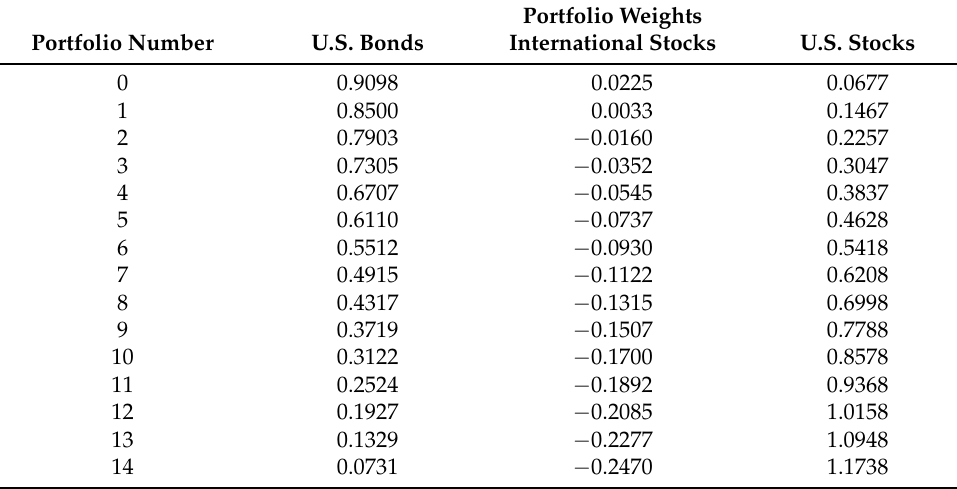
Table 2. The portfolio weights in the three index funds for our 15 portfolios on the efficient frontier, from the most conservative (portfolio 0) to the most aggressive (portfolio 14). Both long-only and long-short portfolios are